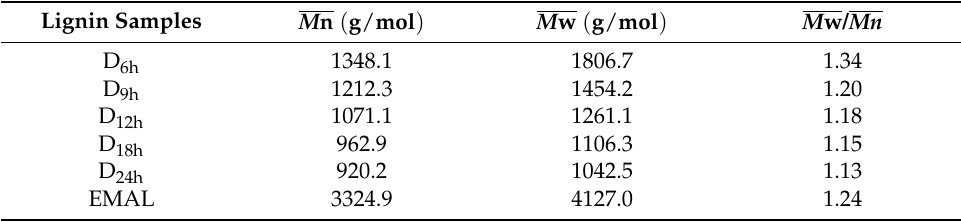
Figure 1. Number average molecular weight ( M n ) and weight average molecular weight DES-lignin samples (D 6h , D 9h , D 12h , D 18h , D 24h ) from willow by DES treatment at 120 °C for 6, 9, 12, 18, and 24 h. The EMAL was extracted from willow by enzymatic/mild acid hydrolysis treatment. Table 3. Average molecular weight and polydispersity of DES-lignin samples (D 6h , D 9h , D 12h , D 18h , D 24h ) and EMAL. ( M n): number average molecular weight which can be averaged according to the number of molecules; ( M w): weight average molecular weight which can be averaged according to the weight of molecules; M w/ M n: